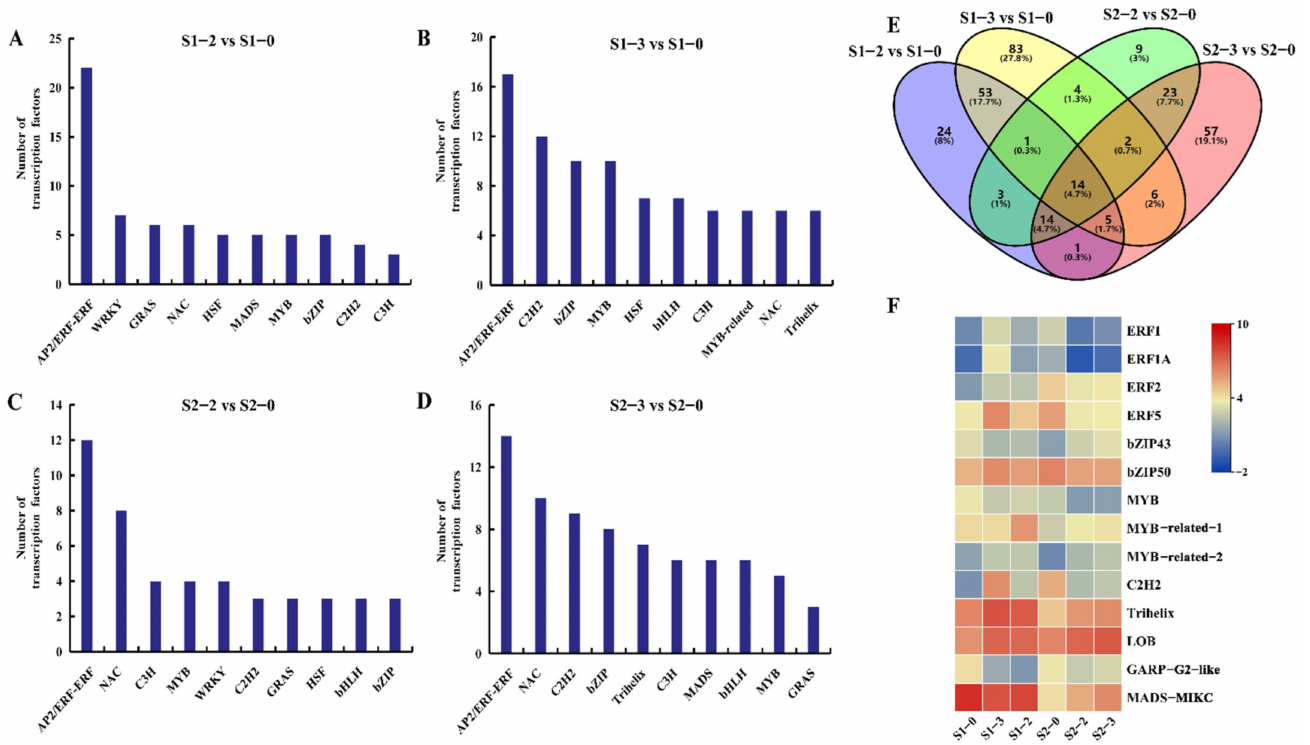
Figure 5. The distribution of differentially expressed transcription factors in apple fruit under different nitrogen levels. ( A – D ) The number of differentially expressed transcription factors in S1–2 vs. S1–0, S1–3 vs. S1–0, S2–2 vs. S2–0, and S2–3 vs. S2–0, respectively. ( E ) Venn diagram of differentially expressed transcription factors. ( F ) Heat map of differentially expressed transcription factors co-expressed in two